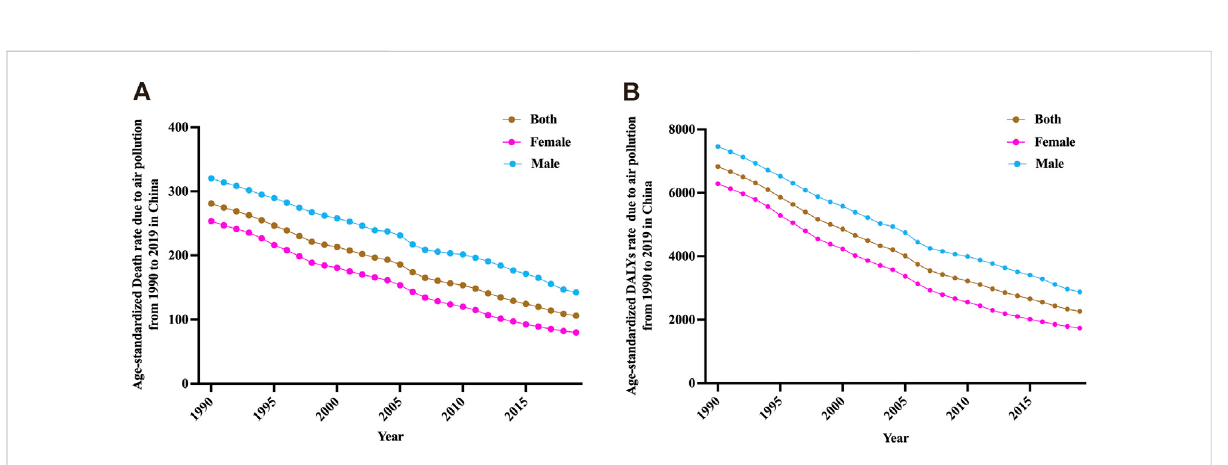
FIGURE 1 Age-standardized disease burden due to air pollution in China from 1990 to 2019. Age-standardized death (A) and DALYs (B) rate. DALYs, disability-adjusted life